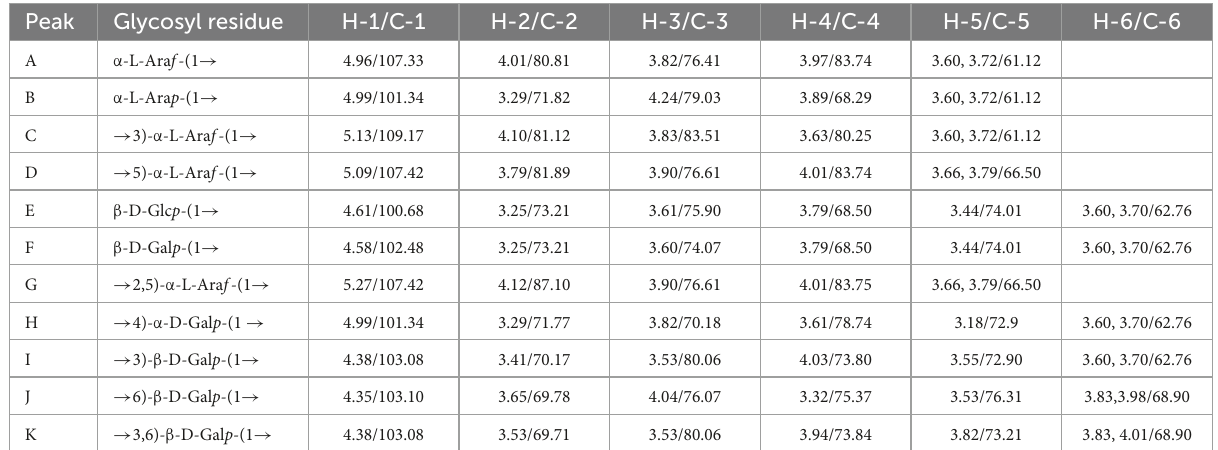
TABLE 2 1 H and 13 C NMR chemical shifts for